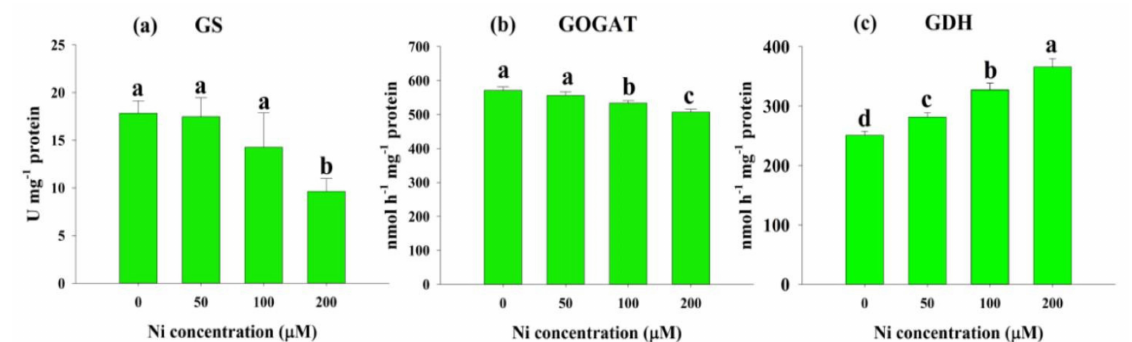
Figure 5. Effects of nickel (Ni) on the activity of glutamine synthetase (GS) ( a ), glutamate synthase (GOGAT) ( b ), and glutamate dehydrogenase (GDH) ( c ) in the leaves of rice seedlings exposed to 0, 50, 100 and 200 µ M Ni for a period of 14 days. Bars represent means ± standard deviations (SDs) of three independent replications ( n = 3). Means followed by the same letter did not significantly differ among the treatments at p < 0.05, according to Fisher’s least significant difference